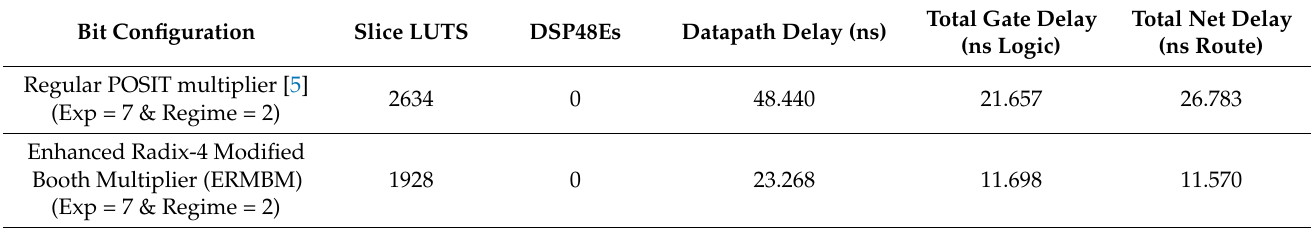
Table 5. Comparison of the regular multiplier with ERMBM for area and speed.